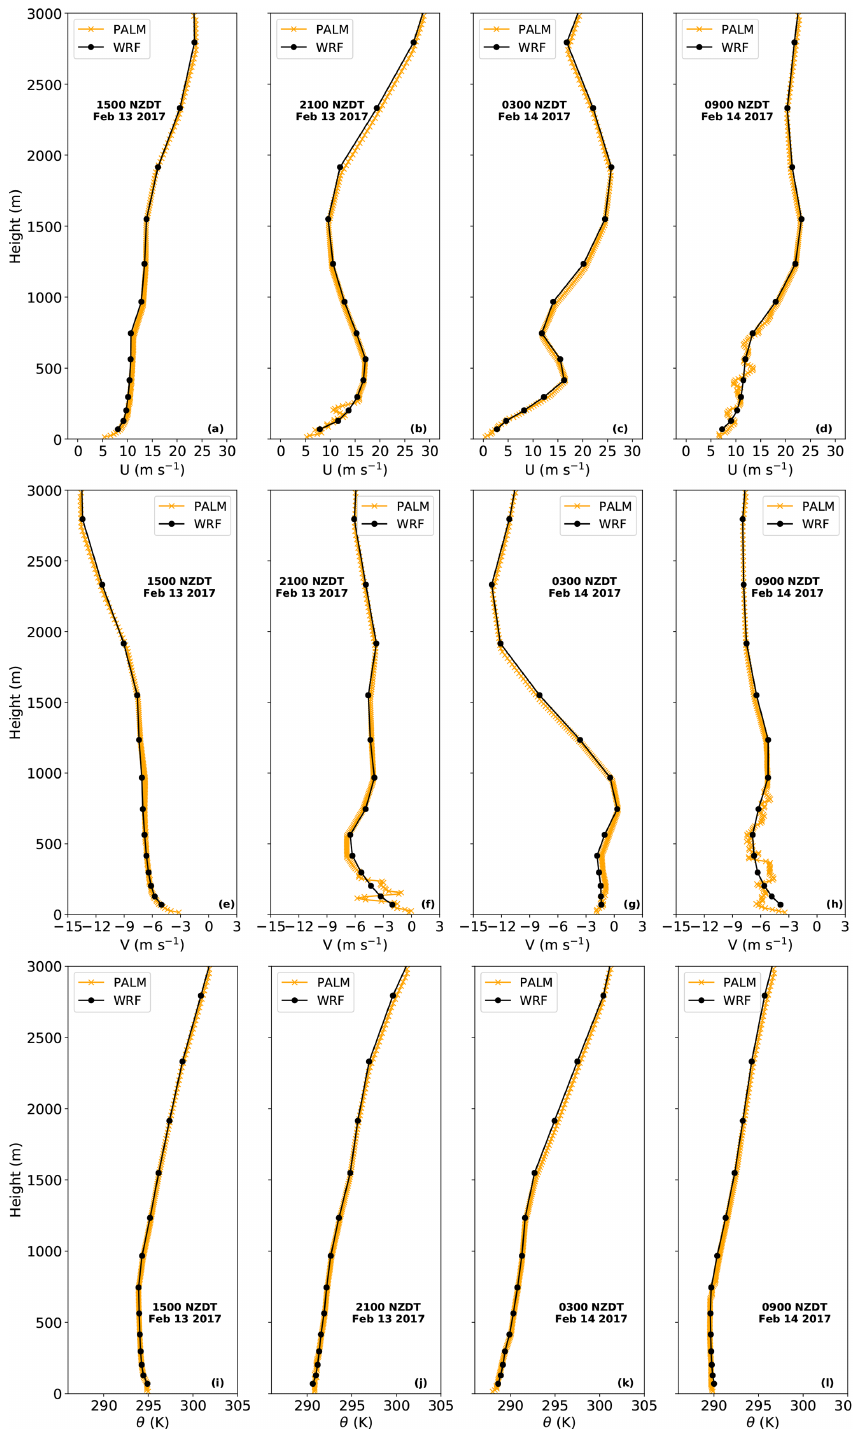
Figure 6. The north-westerly case. Vertical profiles of the u component of winds (a–d) , v component of winds (e–h) , and potential tempera- ture ( θ ) (i–l) taken from PALM and the WRF model at the times indicated in the figures (from left to